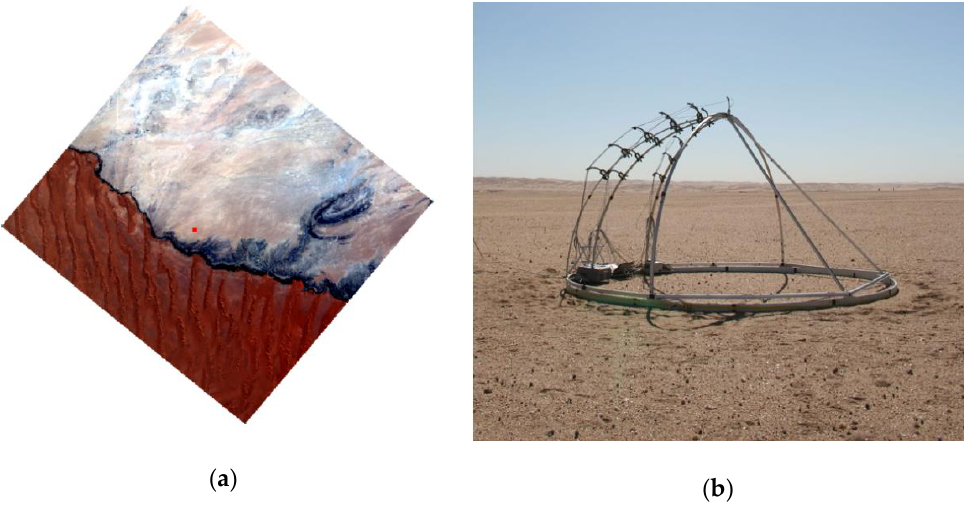
Figure 2. DESIS image of Gobabeb ( a ) and site view ( b ).